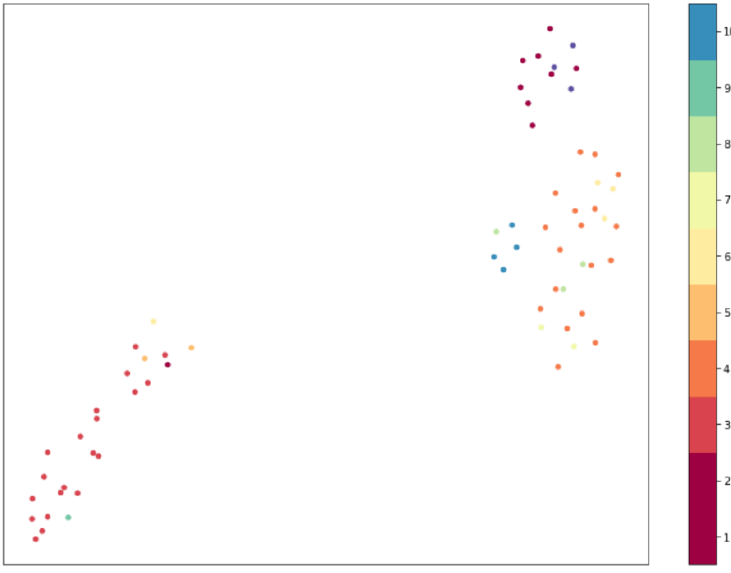
Figure 18. Image prediction and classification with UMAP. Table 4. Image prediction classification with supervised model.